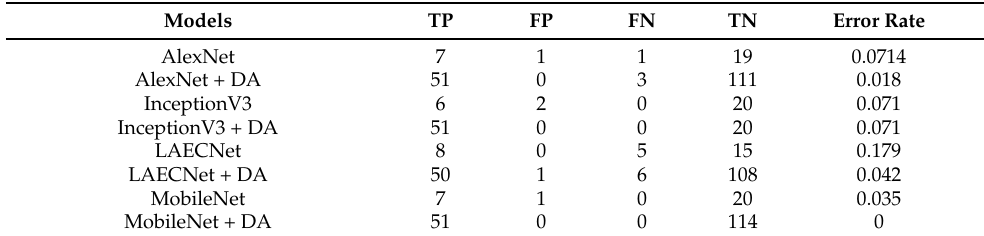
Table 6. Test performance of the proposed crack